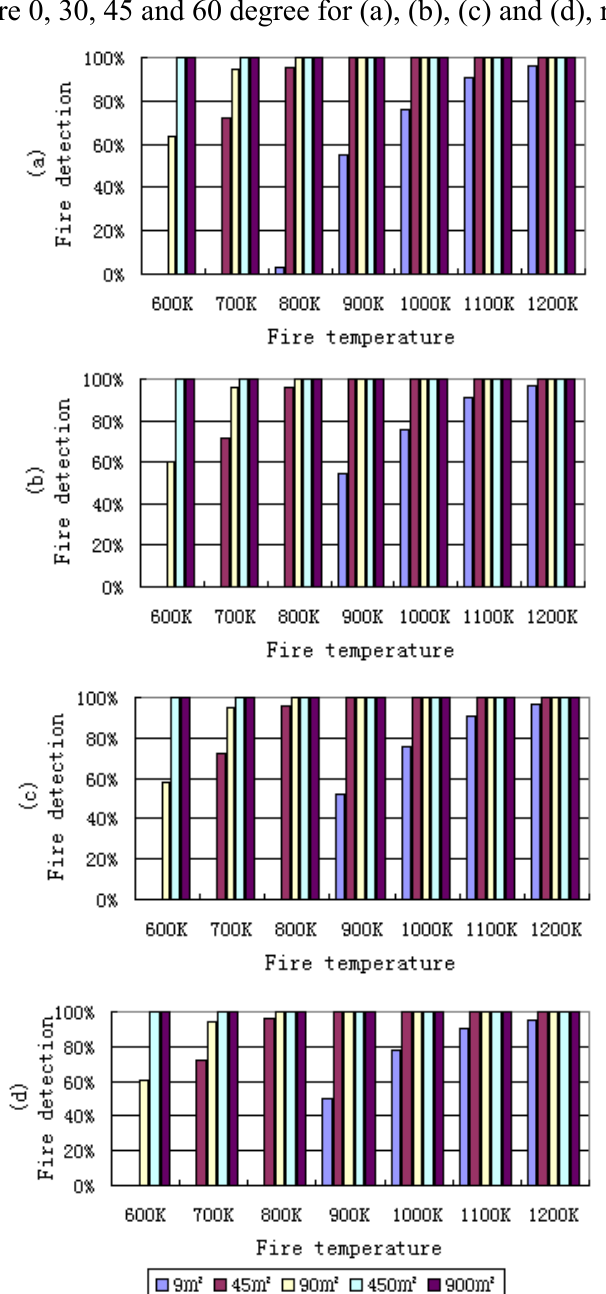
Figure 5. Probabilities of fire detection in nadir view for different fire area (m 2 ) and temperature (K) under US standard atmospheric conditions with a visibility of 23 km. The solar zenith angles are 0, 30, 45 and 60 degree for (a), (b), (c) and (d),